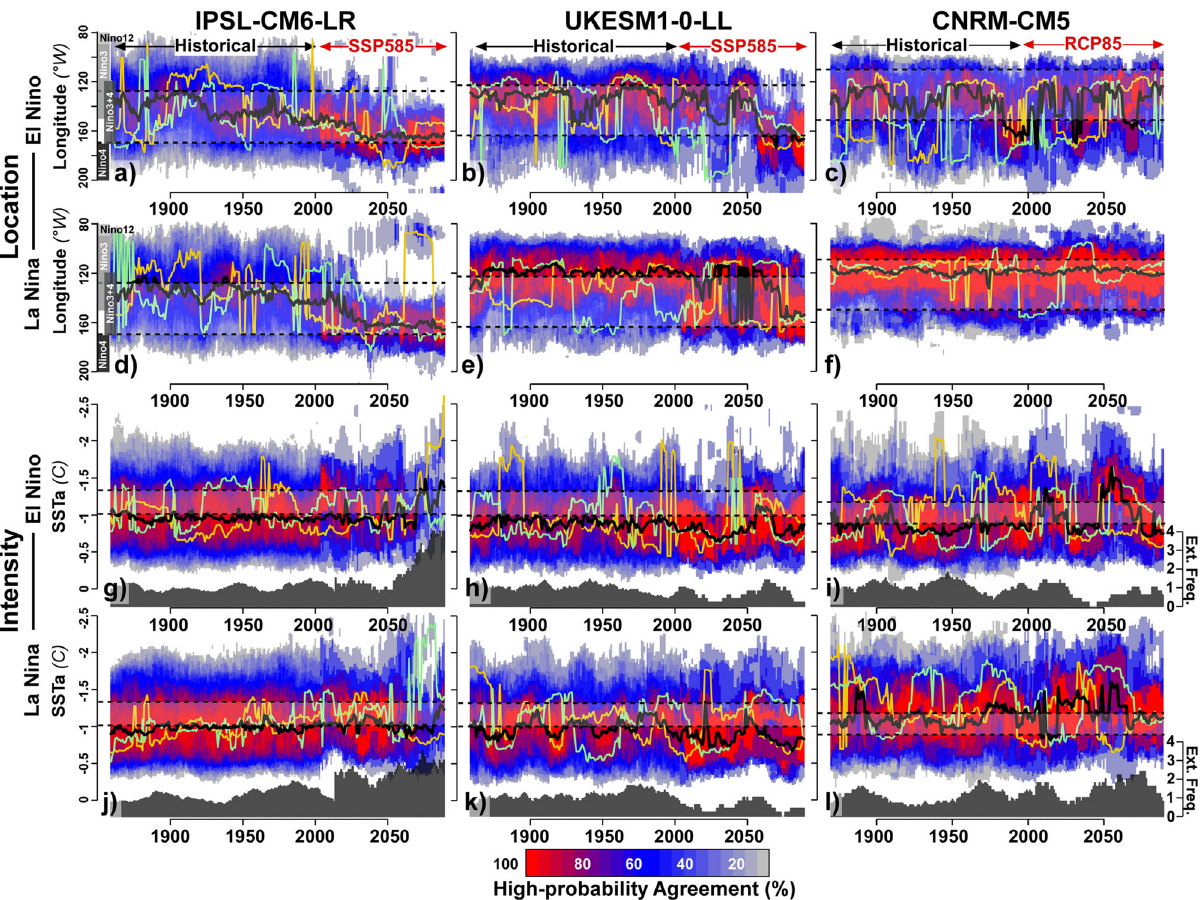
Fig. 7 Future scenarios for ENSO diversity in the most realistic models. Twenty-year most likely location of El Niño events in ( a ) the IPSL-CM6-LR, ( b ) UKESM1-0-LL and, ( c ) CNRM-CM5 ensemble mode (black bold lines), in two contrasted individual simulations (light green and yellow lines), and the percentage of agreement of high-probability within the full ensemble (PDF exceeding 0.01 and 0.45; colour shades). d – f Same as ( a – c ) but for La Niña events. g – l Same as ( a – f ) but for El Niño and La Niña intensity. Grey histograms on the bottom axis of the intensity panels indicate the average number of extreme events (as de fi ned in Fig. 2) within the full-model ensemble. Dashed lines and grey shading indicate the range of variability that could be obtained in a random fi eld at p = 0.05. SSTa is estimated by removing the 1850 – 2014 monthly climatology and trend, to allow comparison with observations. The same baseline period was used to estimate the 90 th and 10 th